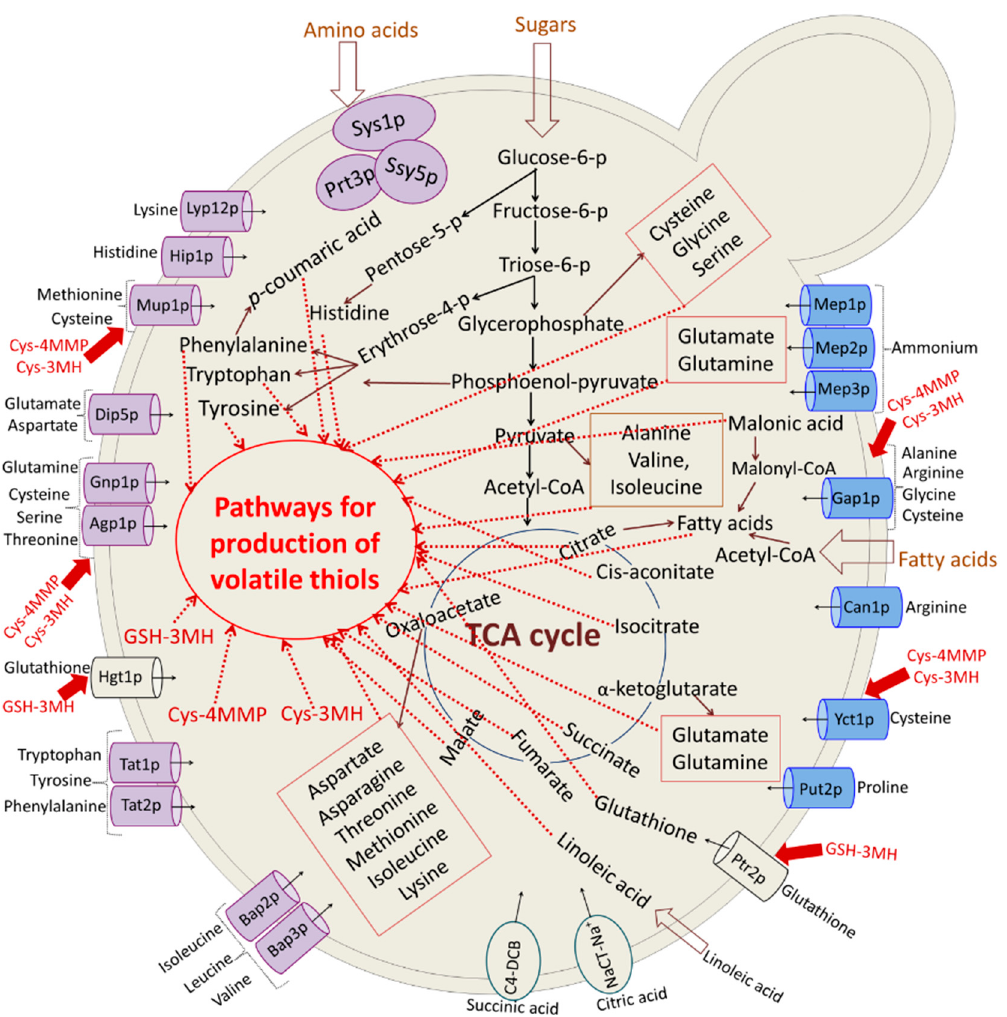
Figure 3. The anticipated metabolic network related to varietal thiol pathways in Saccharomyces cerevisiae based on the metabolomics data published by Pinu, Edwards, Jouanneau, Kilmartin, Gardner and Villas-Boas [34]. This figure shows the transport mechanisms of different metabolites into the yeast cells. The amino acid transporters regulated by Ssy-Ptr3-Ssy5 (SPS) genes are shown in purple and the transporters regulated by nitrogen catabolite repression (NCR) are shown in blue. It also presents the major pathways of yeast metabolism and how they are connected to the formation of volatile thiols. The red (solid) arrows indicate the suggested ways for the transportation of putative precursors to the yeast cells, while the dashed red arrows indicate which metabolites (e.g., nitrogenous compounds, organic acids and fatty acids) influence the production of varietal thiols in Sauvignon blanc wines. The information for this figure was collated from Pinu [13], Aliverdieva , et al. [142], Crépin , et al. [143], Cooper [144], Hofman-Bang [145], Henscke and Jiranek [146]. Here, cys-3MH and cys-4MMP denote the cysteinylated precursors of 3-mercaptohexanol (3MH) and 4-mercapto-4-methylpentan-2-ol, respectively, and GSH-3MH is the glutathionylated precursor of 3MH.